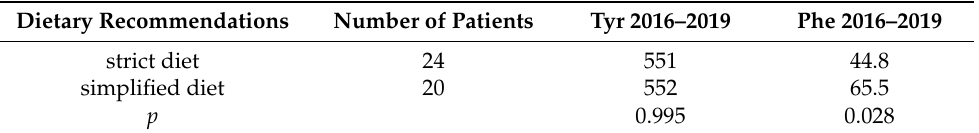
Table 4. Mean tyrosine (Tyr) and phenylalanine (Phe) concentrations in µ mol/L for centers with strict or simplified diet in the period 2016–2019; p -values: strict vs. simplified diet.